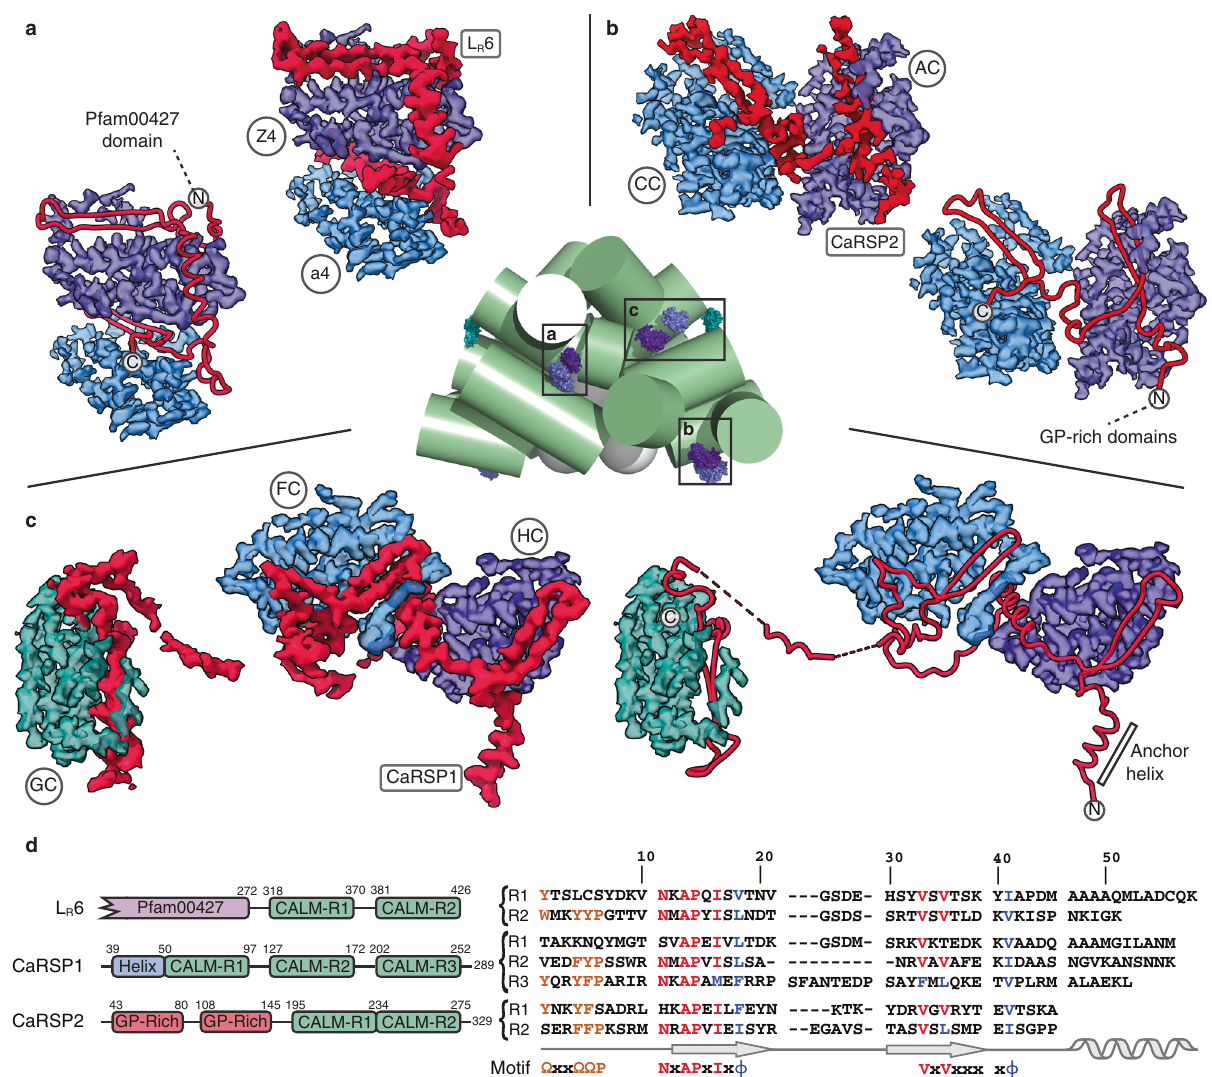
Fig. 2 The CaRSPs of P. purpureum . a – c sculpted EM map density for L R 6, CaRSP2, and CaRSP1, respectively (red), with their associated PE β subunits (coloured purple-blue-teal by their order in the cluster). Both the density and the peptide trace are shown for each CaRSP. A reference to the positions of each cluster is given in the central panel. d the domain organization of the three P. purpureum CaRSPs (left) and the structure-based alignment of the modelled CALM domains (right). Residue numbers of the beginning and end of each domain are shown (left). Structure and sequence motifs are shown (right; Ω = Y/F/W and ɸ = hydrophobic with orange being the aromatic motif, and red and blue signifying identity and similarity, (Fig. 1g, Supplementary Figs. 3, 4a, g, h). The level of sequence identity observed is comparable to that of cryptophyte α subunits (Fig. 1g, Supplementary Fig. 3). We have named the complete motif a CALM domain (cryptophyte α -like motif).